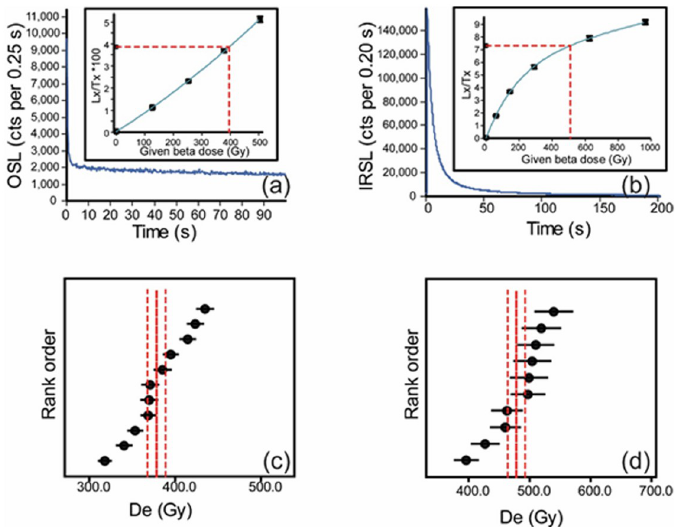
Fig 6. Luminescence results for sample JAL-10. Aliquot size, stimulation source, fits and integration channels are listed in Table 2. (a) Natural TT-OSL signal (in blue) for one large aliquot (~1500 grains) of quartz grains, displaying the rapid decay of the signal within a few seconds, and the slow background decay. Inset: Dose response curve for the same aliquot. De = 395 ± 8 Gy. The recycling ratio (RR; the repeated measurement point at 120 Gy) = 1.07 and recuperation = 0.95%. (b) Natural pIR-IR 290 signal (in blue) for one small aliquot (~50 grains) of alkali-feldspar grains. Inset: Dose response curve for the same aliquot. De = 511 ± 29 Gy. RR = 0.99 and recuperation = 0.4%. De is not sensitive to the selected channels. (c) Rank order plot for TT-OSL measurements, showing all 11 accepted aliquots. Average De, calculated using the central age model (CAM), is 378 ± 11 Gy, and over-dispersion (OD) = 9%. (d) Rank order plot for pIR-IR 290 measurements, showing all 10 aliquots. Average De, calculated using CAM, is 478 ± 14 Gy and OD = 8%.